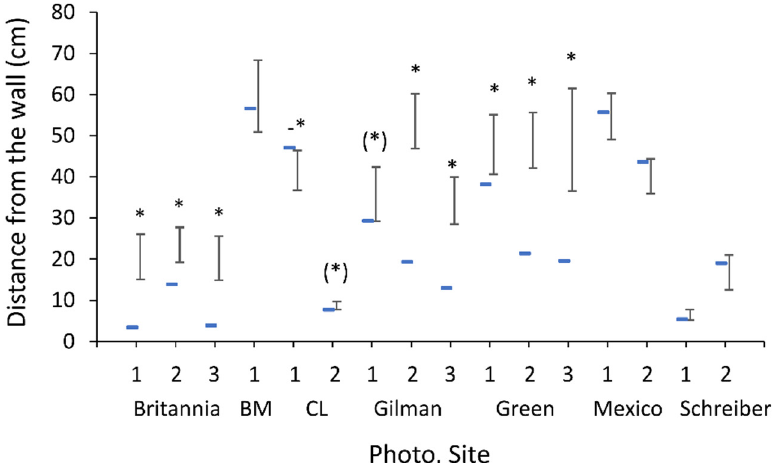
Figure 2. The observed mean distance from the wall (horizontal line) and the expected distance (vertical lines, 95% confidence intervals, determined by bootstrap), separately per site (name) and photo (number). BM and CL stand for Buchmann-Mehta and Central Library. *, (*), and -* stand for an observed distance shorter than expected by chance, a marginally non-significant result in the same direction, and an observed distance longer than expected by